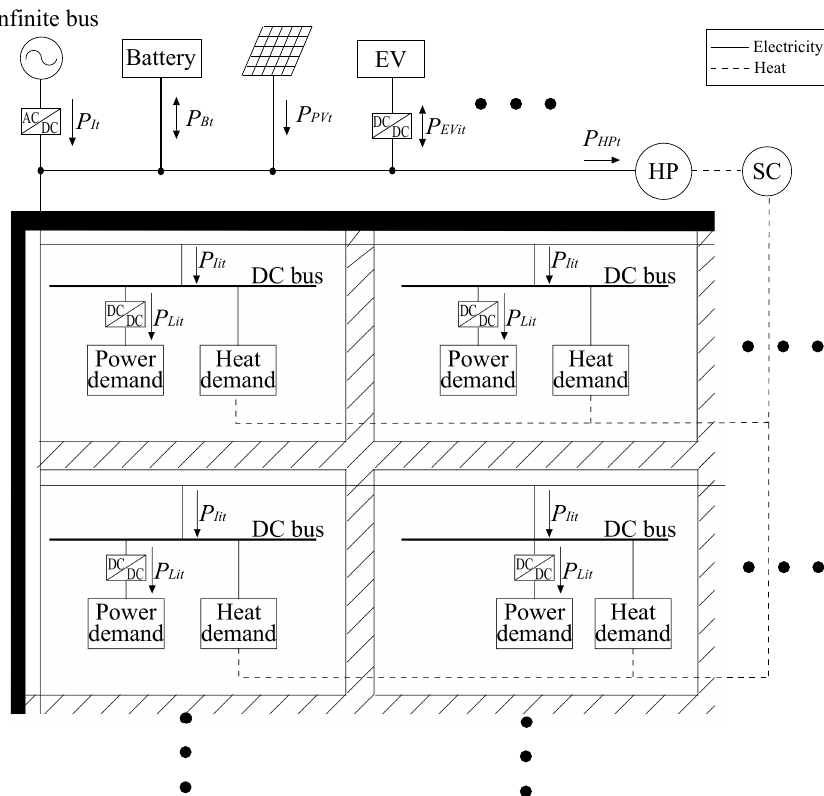
Figure 1. The smart apartment building model.